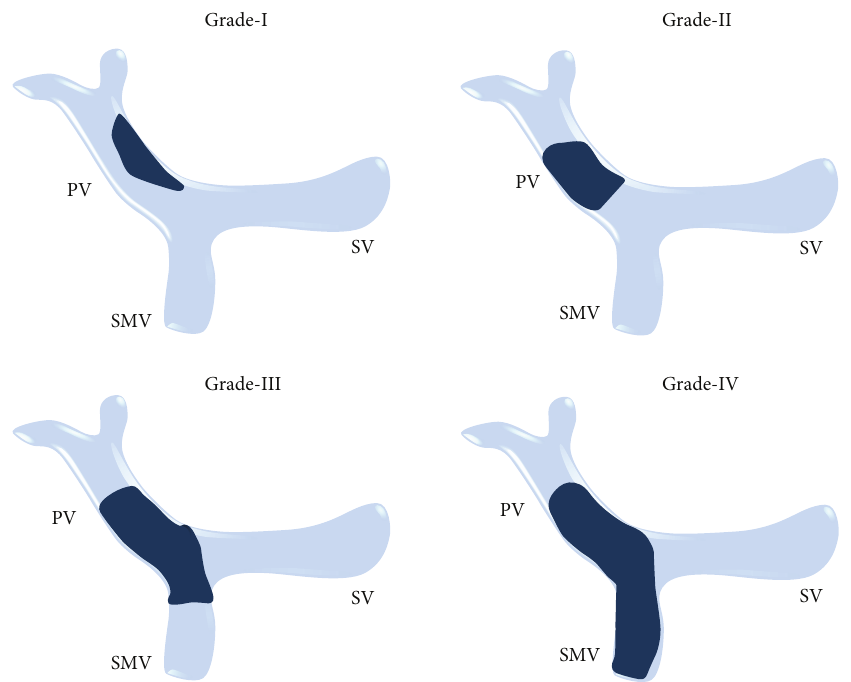
Figure 32: Classification of PVT proposed by Yerdel et al.